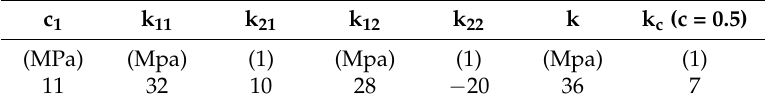
Table 2. The parameters of the model for envelope materials under equal loading ratios.